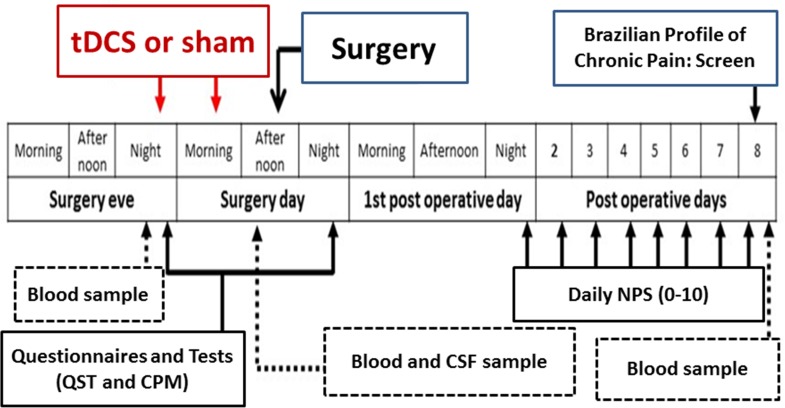
Experimental design—Assessments and interventions on each patient.